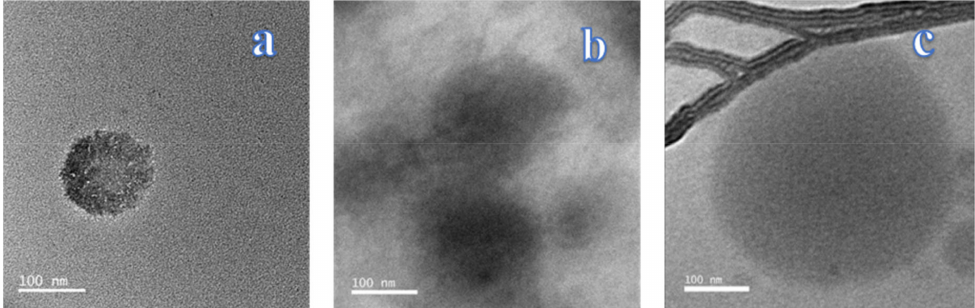
Figure 2. Transmission Electron Microscopy (TEM) images of OEO-loaded NE I ( a ) NE II ( b ) and NE III ( c